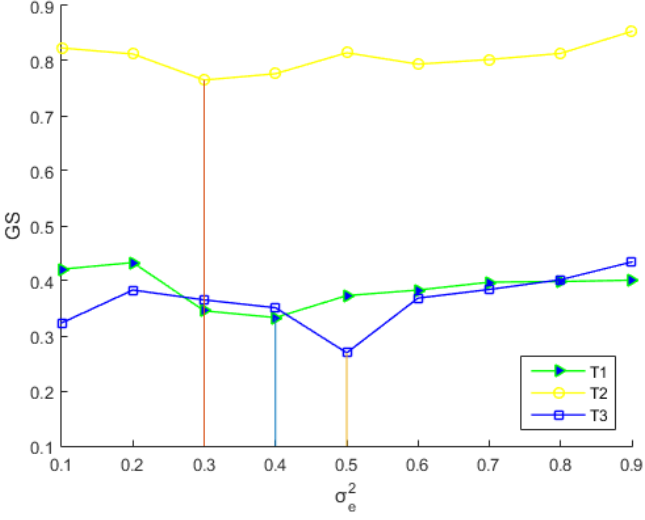
(cid:0) (cid:1) of MMHS with the three σ 2 e of MMHS with the three 2 ( 𝜎𝜎 𝑒𝑒 )